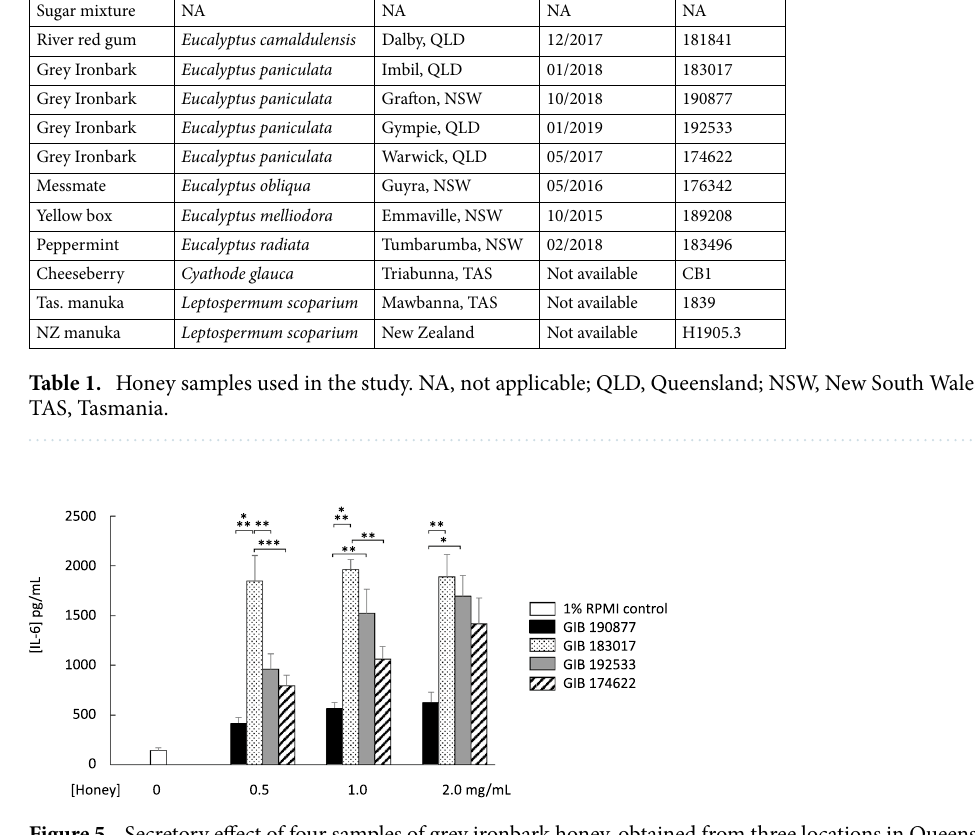
Figure 5. Secretory effect of four samples of grey ironbark honey, obtained from three locations in Queensland and one location in New South Wales (Table 1). The secretory response was non-uniform for this floral source of honey. Data are mean ± SEM; * p < 0.05, ** p < 0.01, *** p < 0.001; n = 3–4. Statistical analysis was performed using a one-way